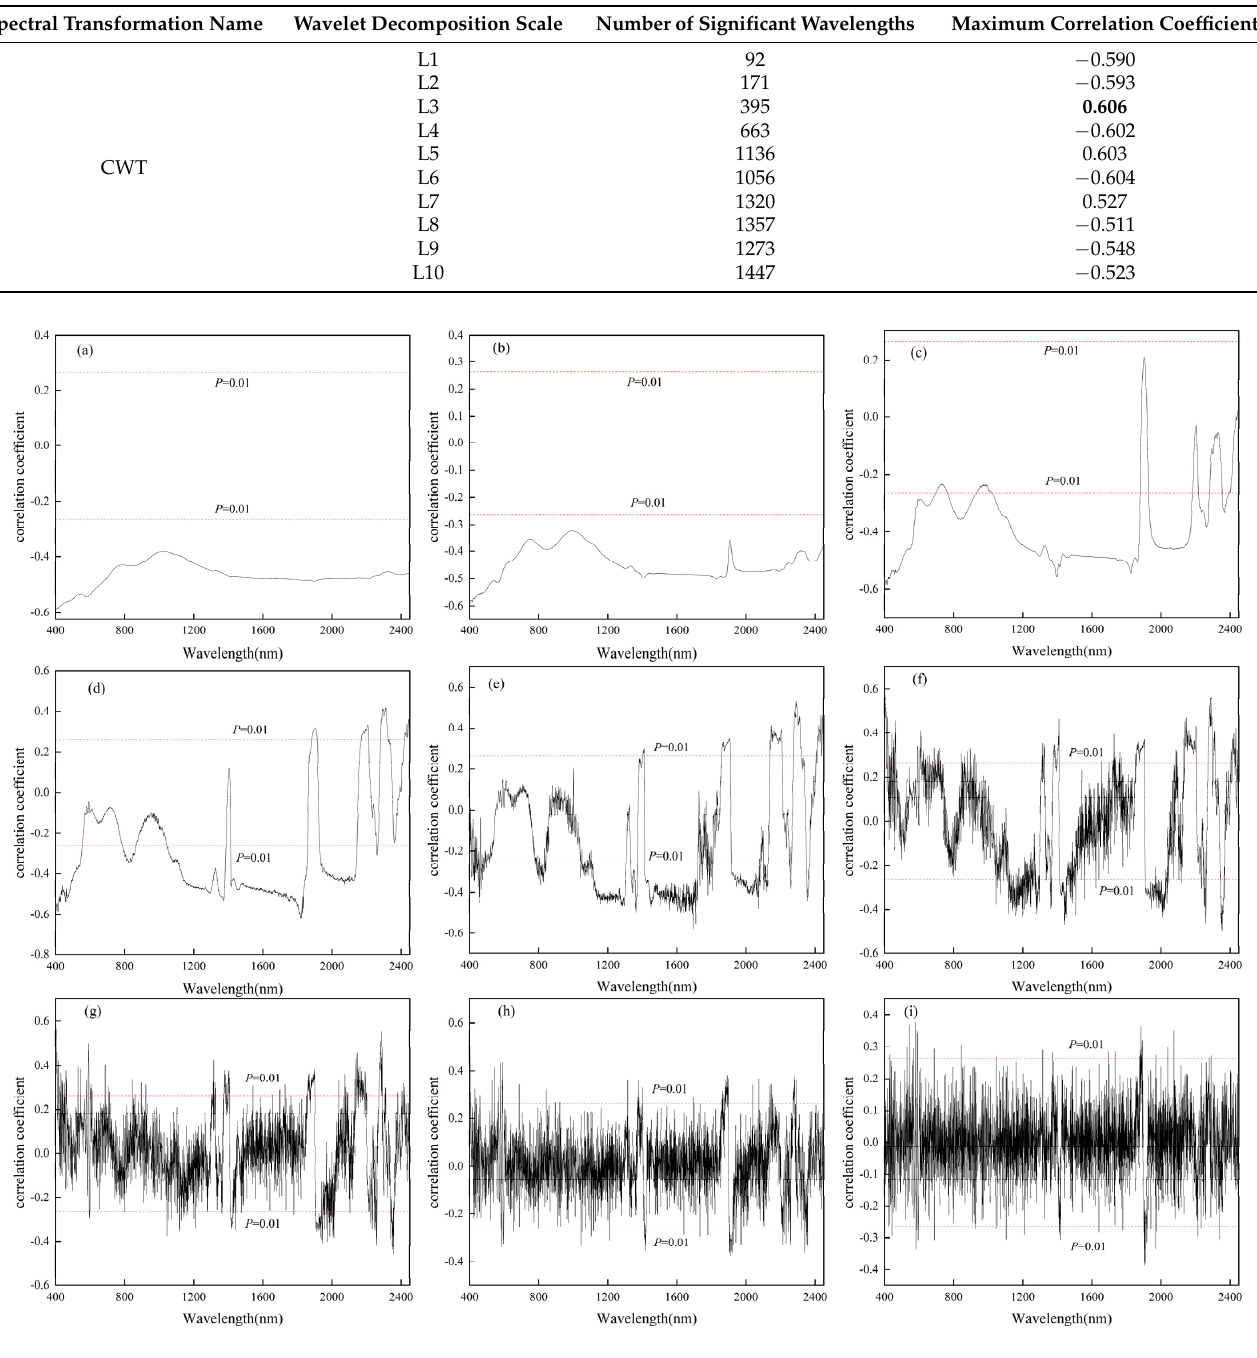
Figure 8. The correlation coefficients between the FOD spectra in the calibration dataset and the soil iron oxide content: ( a ) original spectra; ( b ) 0.25-order, ( c ) 0.5-order; ( d ) 0.75-order; ( e ) 1-order; ( f ) 1.25-order; ( g ) 1.5-order; ( h ) 1.75-order; ( i ) 2-order. Table 4. The number of wavelengths passing the significance test ( p < 0.01) and the maximum cor- relation coefficient for different order in FOD.